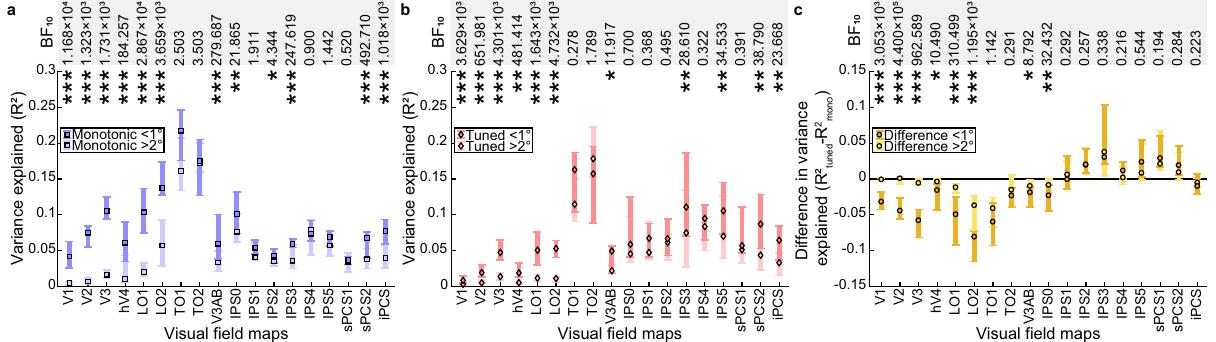
Fig. 6 Model fi ts decrease with distance from the stimulus area, but the additional response variance explained by the timing-tuned model is not affected in visual fi eld maps where the tuned response model fi ts better. a Cross-validated variance explained by the monotonic response model in eccentricity ranges near and far from the stimulus area. b Cross-validated variance explained by the tuned response model in eccentricity ranges near and far from the stimulus area. In both cases, responses are clearer near the stimulus area in many visual fi eld maps. c The difference in cross-validated variance explained between the two models was signi fi cant only in V1, V2, V3, hV4, LO1, LO2, V3AB, and IPS0, where the monotonic response model fi t better than the tuned response model. Markers show the median variance explained in each visual fi eld map, error bars show the 95% con fi dence interval, computed from 1000 bootstrap iterations. Only voxels that had a variance explained above 0 for the best fi tting model in the data on which the models were fi t are included. Signi fi cant differences between the near and far eccentricity ranges (two-sided Wilcoxon signed-rank test, FDR corrected for multiple comparisons): * p < 0.05 ** p < 0.01, and *** p < 0.001. For hV4 n = 28 hemispheres included in the eccentricity range comparison. For LO1 and iPCS n = 31. For all other visual fi eld maps n = 32. Bayes factors (BF 10 ) for each paired comparison are presented in the top row. Source data are provided as a Source Data fi